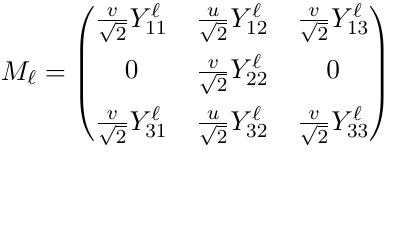
q (cid:0) (cid:1) Figure 23 . (a) The variation of ∆a N with R 2 ≡ Y ν 212 + Y ν 232 for different values of M N µ M N = M N and M . (b) The total contributions in ∆ a µ from the diagrams in figure 21 and 3. H + 3 The grey horizontal line is the allowed 3- σ lower limit [1], while the dashed grey line represents the 3- σ lower limit of a very recent estimate